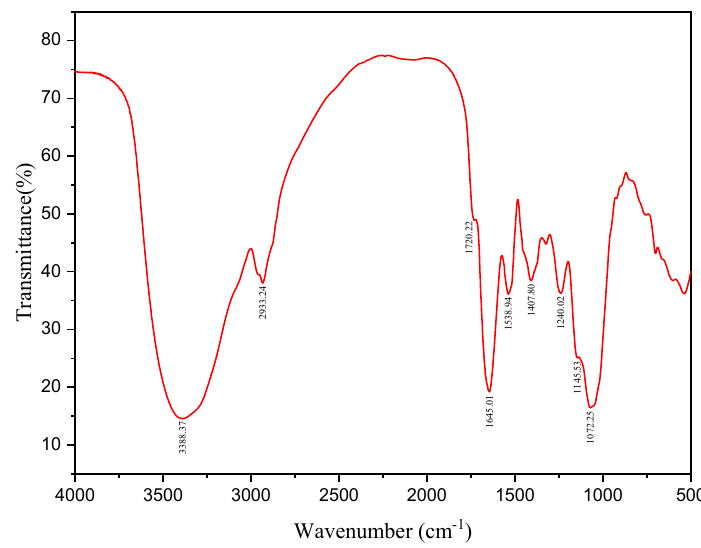
Figure 6. FTIR spectroscopy of FS.